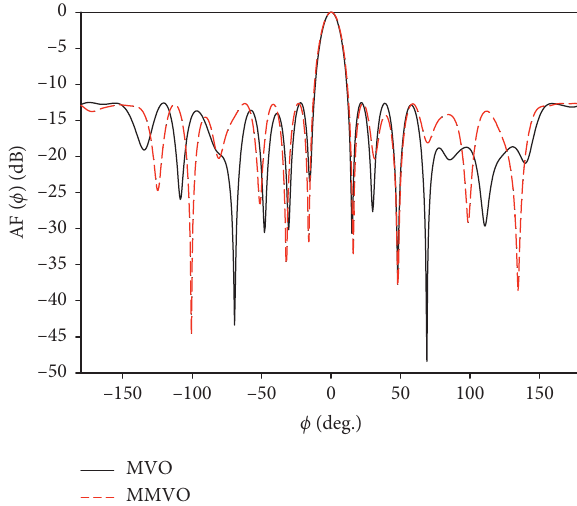
Figure 8: Radiation pattern of the optimized 20-element CAA with 10 λ circumference. Table 3: Amplitude and position values of array elements for design examples.